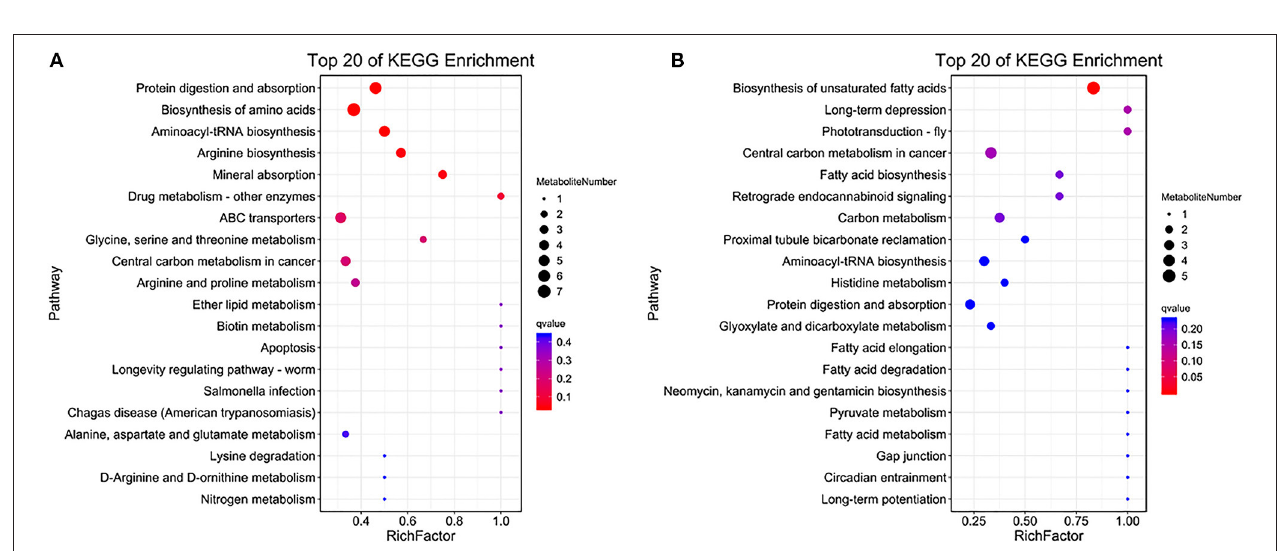
FIGURE 8 | Functional analysis of intestinal metabolites in piglets after starvation. (A) PIM and (B)